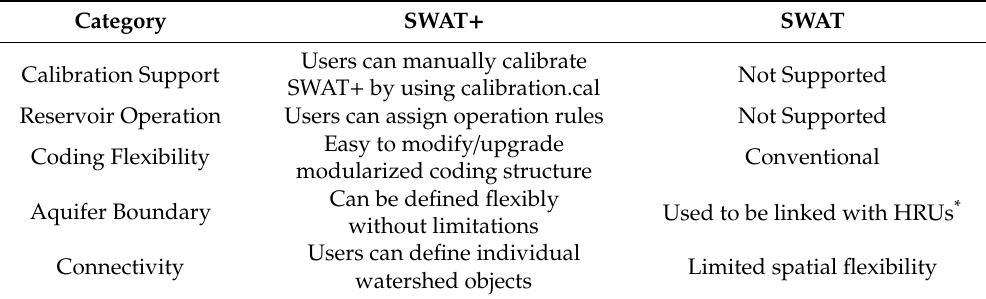
Table 1. Primary di ff erences of functionalities between SWAT and SWAT + . Category SWAT + SWAT Users can manually calibrate Not Supported Calibration Support SWAT + by using calibration.cal Reservoir Operation Users can assign operation rules Not Supported Easy to modify / upgrade Conventional Coding Flexibility modularized coding structure Can be defined flexibly Aquifer Boundary Used to be linked with HRUs * without limitations Users can define Connectivity